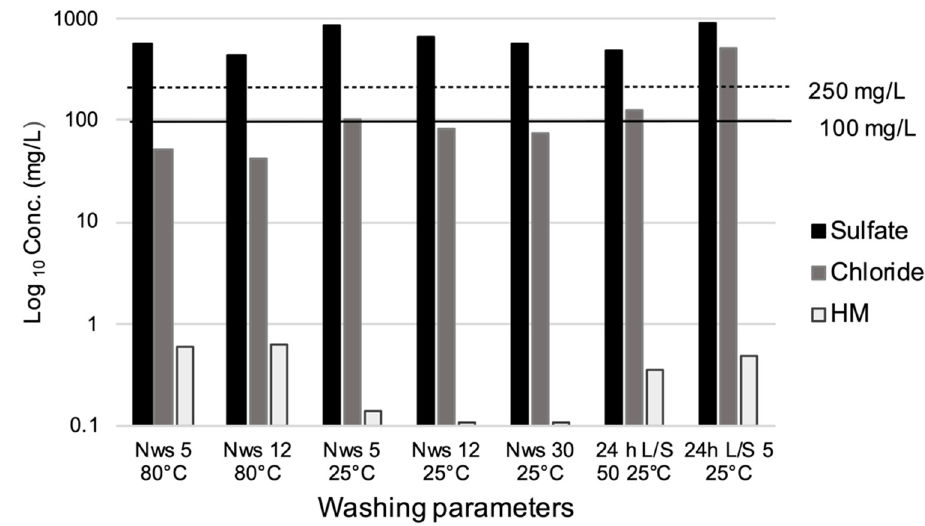
Figure 5. Leaching tests on FA treated by FH-WW, as a function of temperature (25–80 °C) and N ws (5–30); for comparison, the cases of 24 h washing with L/S = 50 and 5 are reported. Attention is focused on chloride, sulfate, and heavy metal (HM) concentrations. Dotted line and solid line: legal limits for reuse in the case of sulfate (250 mg/L) and chloride (100 mg/L), respectively.